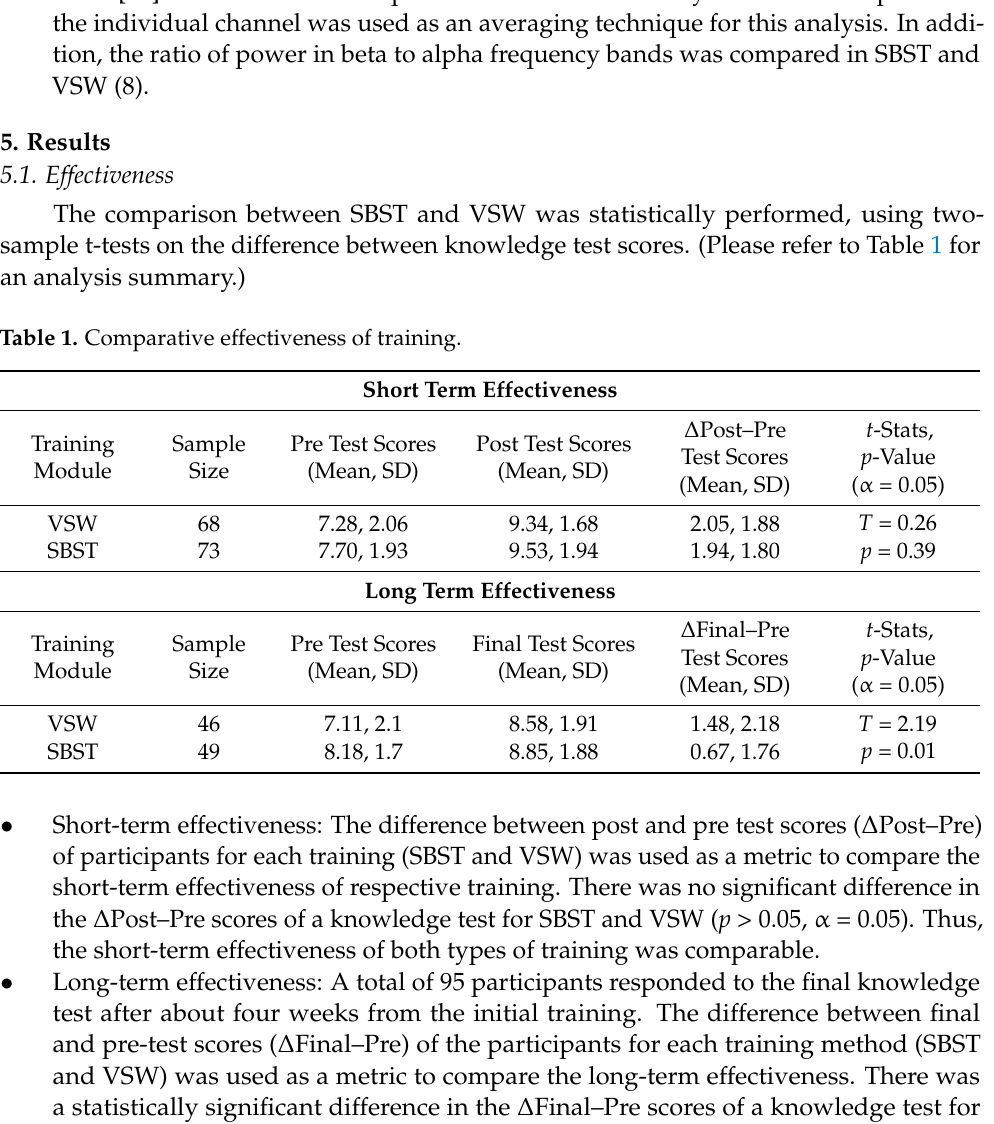
Table 1. Comparative effectiveness of training.